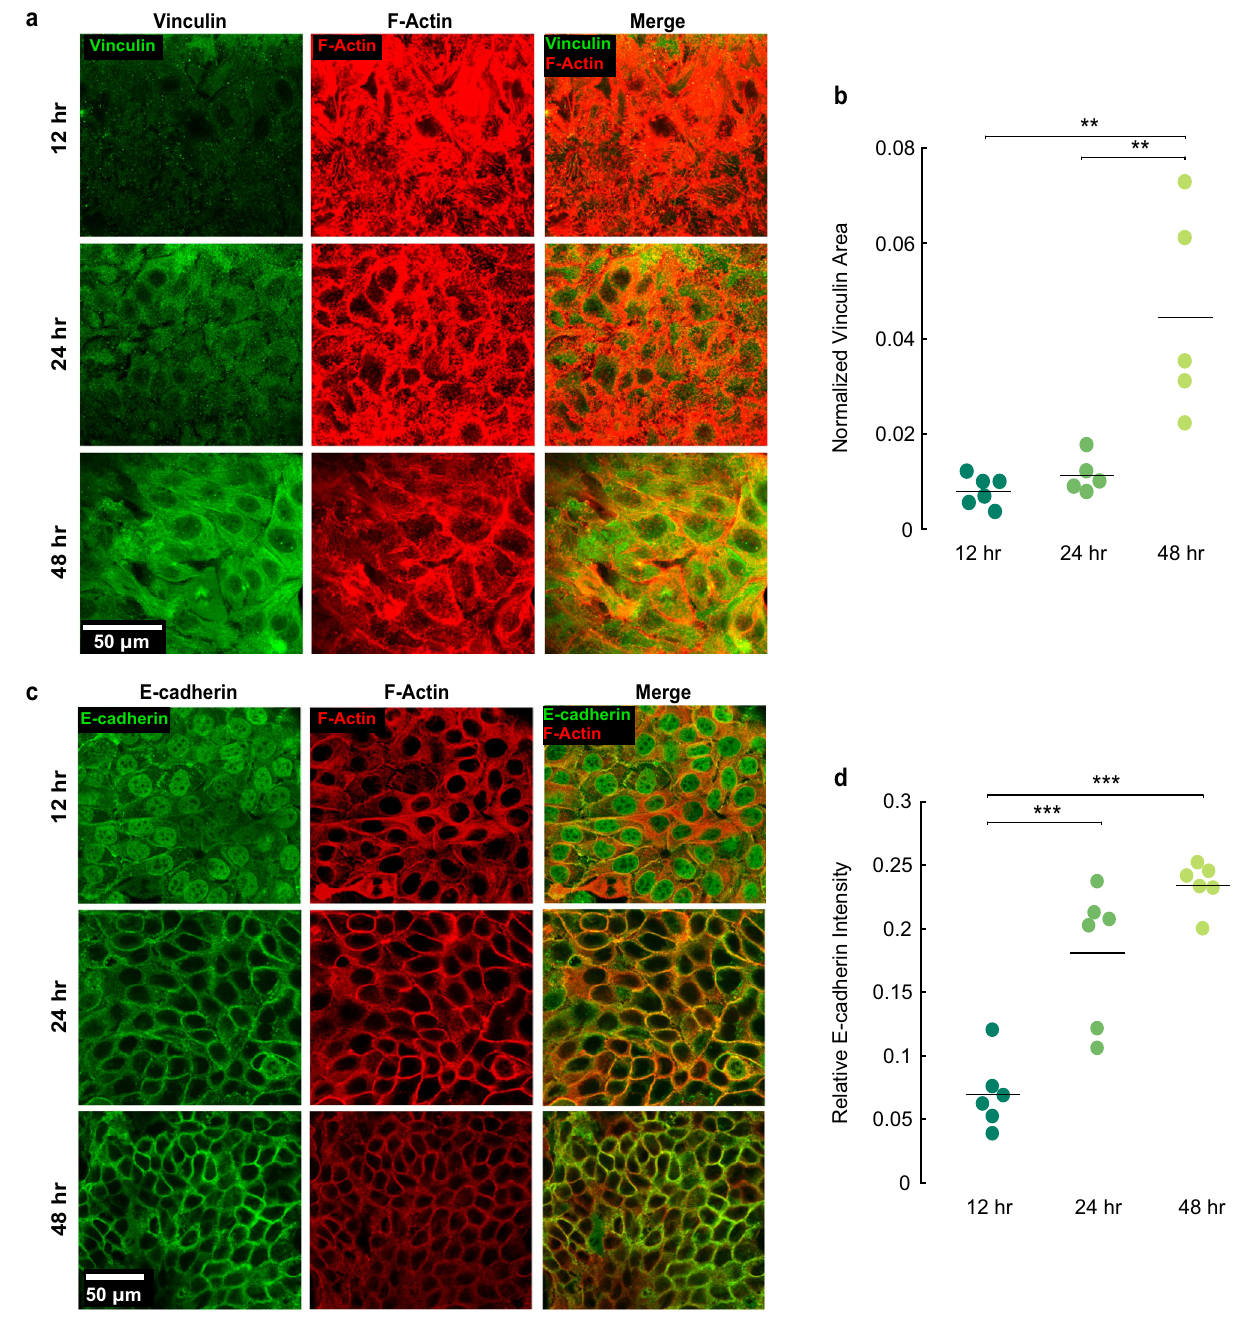
Figure 3. Effect of time in culture on cell–substrate and cell–cell adhesions. ( a ) Confocal images of HaCaTs stained for vinculin (green) and actin (red) after 12, 24, or 48 h in culture on substrates of Young’s moduli 6 kPa. ( b ) Effect of time in culture on normalized vinculin area. ( c ) Confocal images of HaCaTs stained for E-cadherin (green) and actin (red) for varied times in culture. ( d ) Relative E-cadherin intensity (difference between junctional and cytoplasmic intensity divided by the sum) for varied time in culture. For panels ( b , d ), each data point represents an average over a statistically independent field of view. Horizontal lines indicate